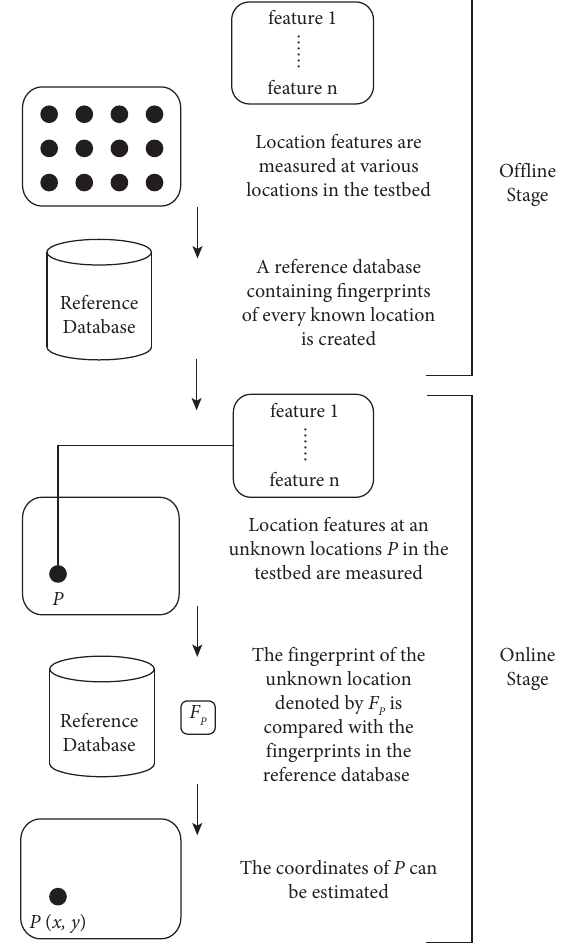
Figure 1: A high-level view of the location fngerprinting